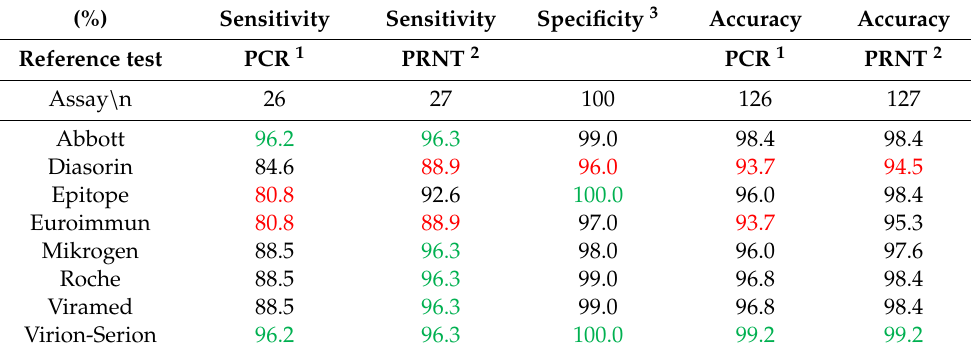
Figure 1. Detection of severe acute respiratory syndrome coronavirus 2 (SARS-CoV-2) immunoglobulin G (IgG)/total antibodies in PCR-confirmed cases. Serum samples (N = 37) obtained from 26 SARS-CoV-2-infected patients (Pat.) were tested. A signal (S)/cut-off (CO) value ≥ 1 is considered as positive for SARS-CoV-2 IgG/total antibodies. The time in days after PCR (d.a.P.) and sample submission, as well as results of the ViraChip ® IgG test (Viramed, VM), of the plaque reduction neutralization assay (PRNT, Figure S1), and of both recom Line assays (blot v1 and v2) are listed in the table. p, positive; n, negative; and nd, not determined. For better clarity, positive test results are printed in red in the table. Table 1. Sensitivities, specificities, and accuracies of eight severe acute respiratory syndrome coronavirus 2 (SARS-CoV-2) immunoglobulin G (IgG) or total antibody assays calculated from the results of two reference tests. The highest values are shown in green; the lowest values are marked in